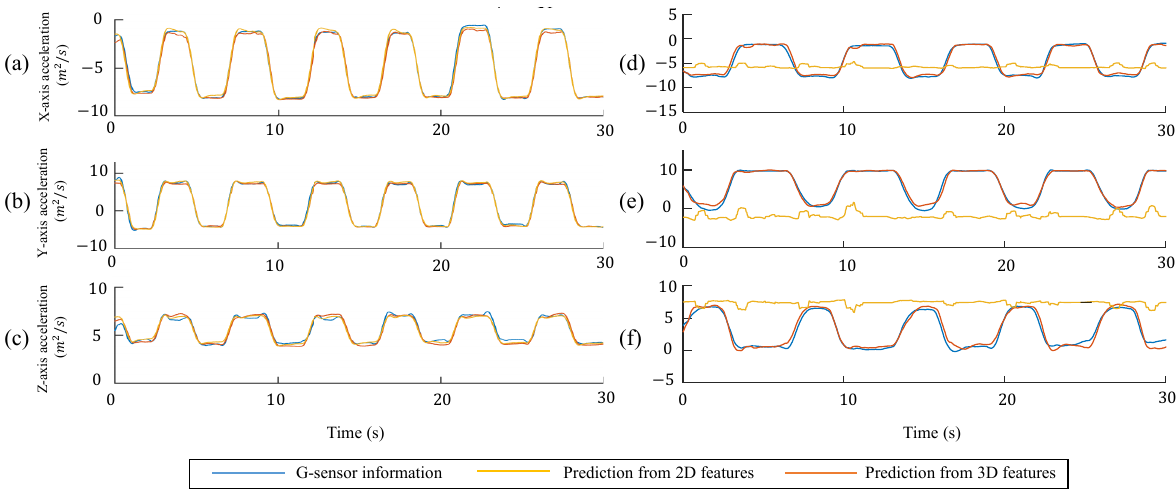
G-sensor information Prediction from 2D features Prediction from 3D features